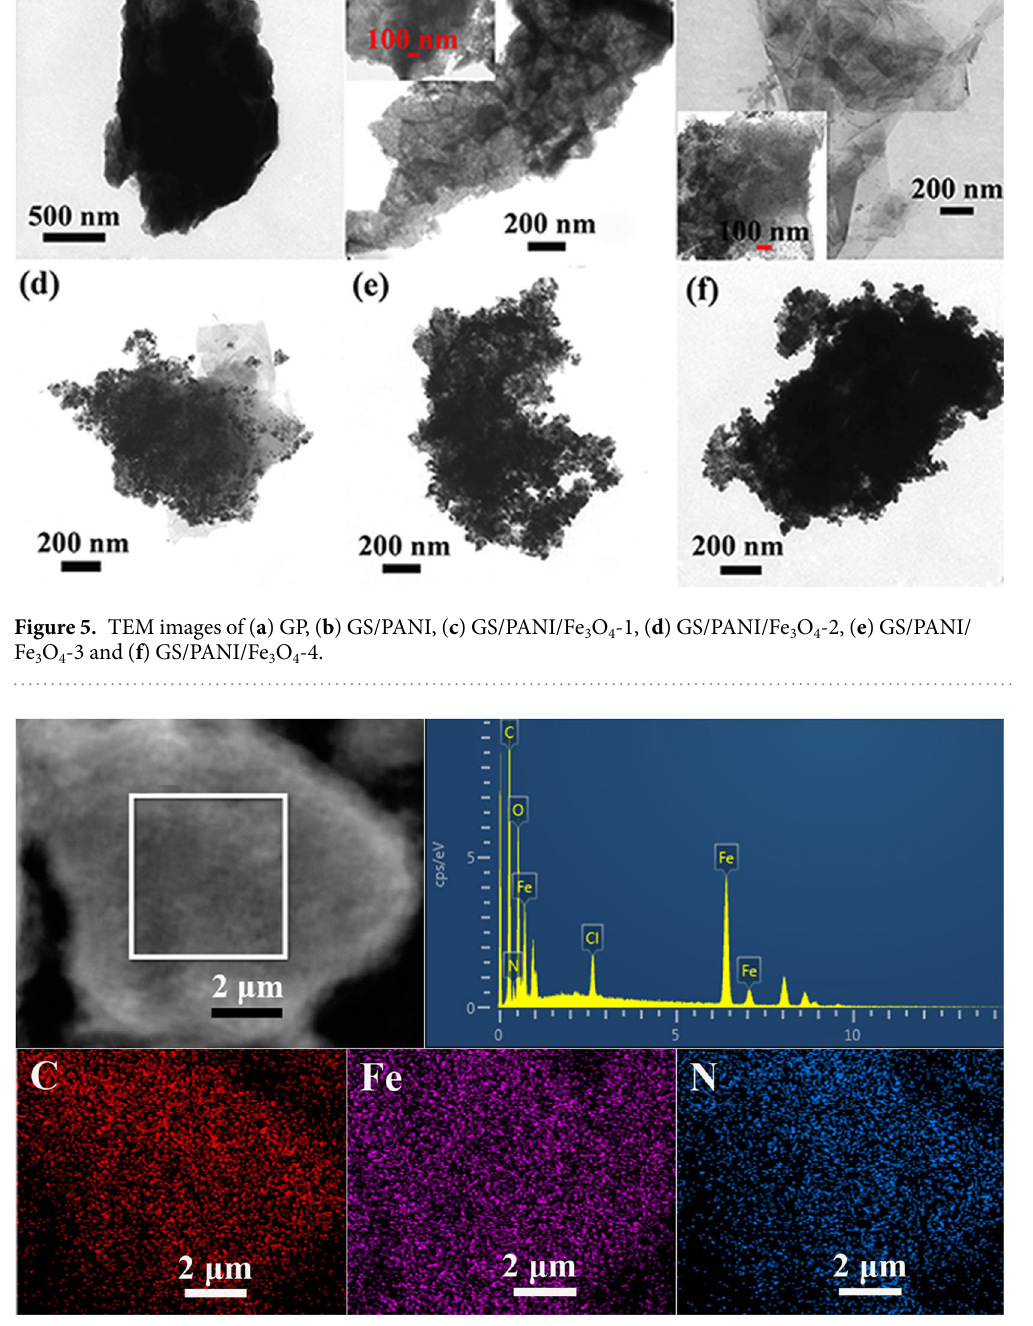
Figure 6. EDS spectrum and elemental mappings of GS/PANI/Fe 3 O 4 -4